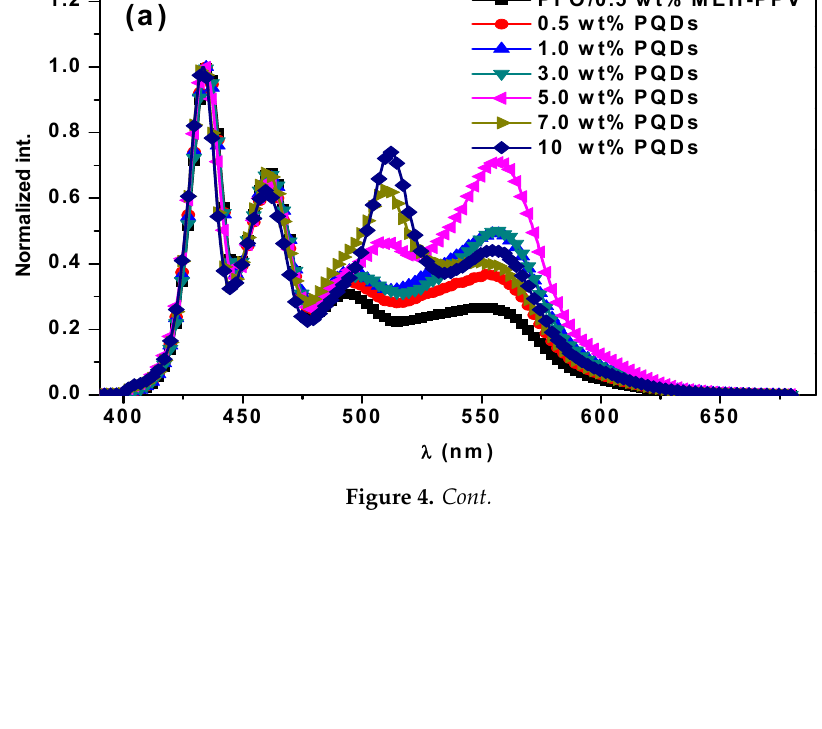
Figure 3. Absorption spectra of the hybrid thin fi lms of PFO/MEH-PPV with various PQD